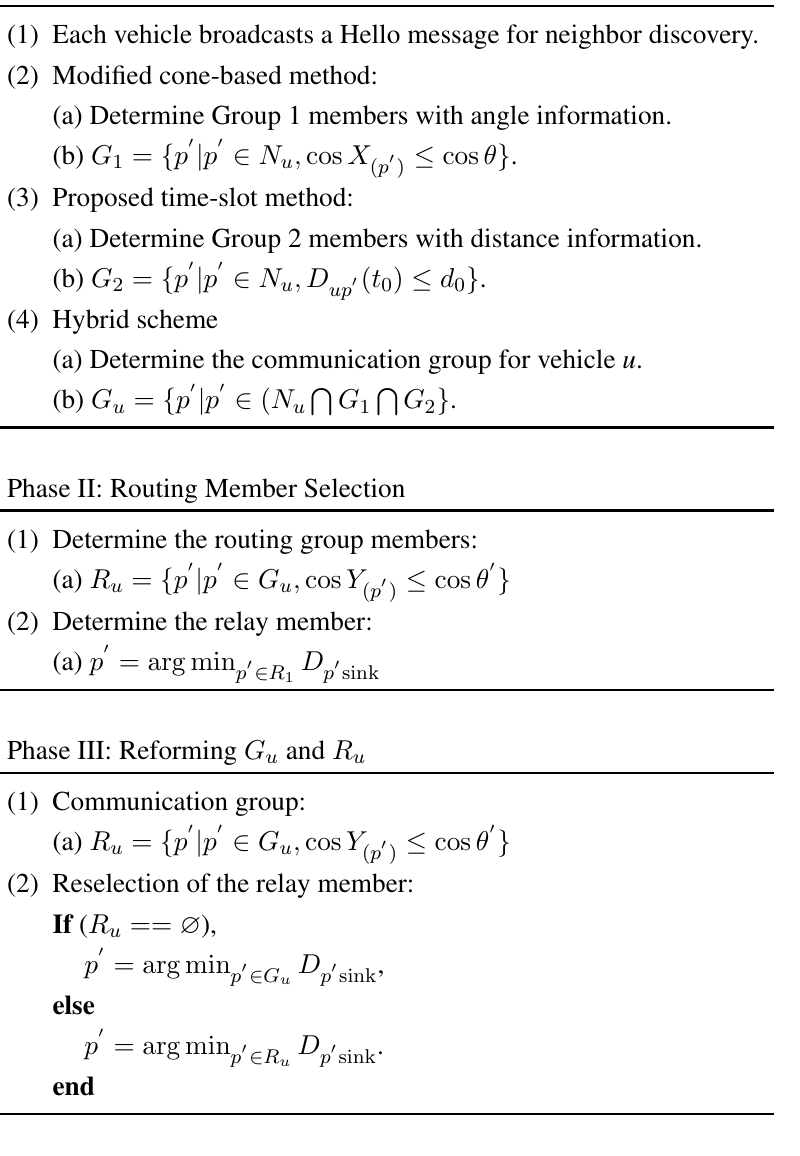
Table 1. Procedures of the HDTC scheme and information